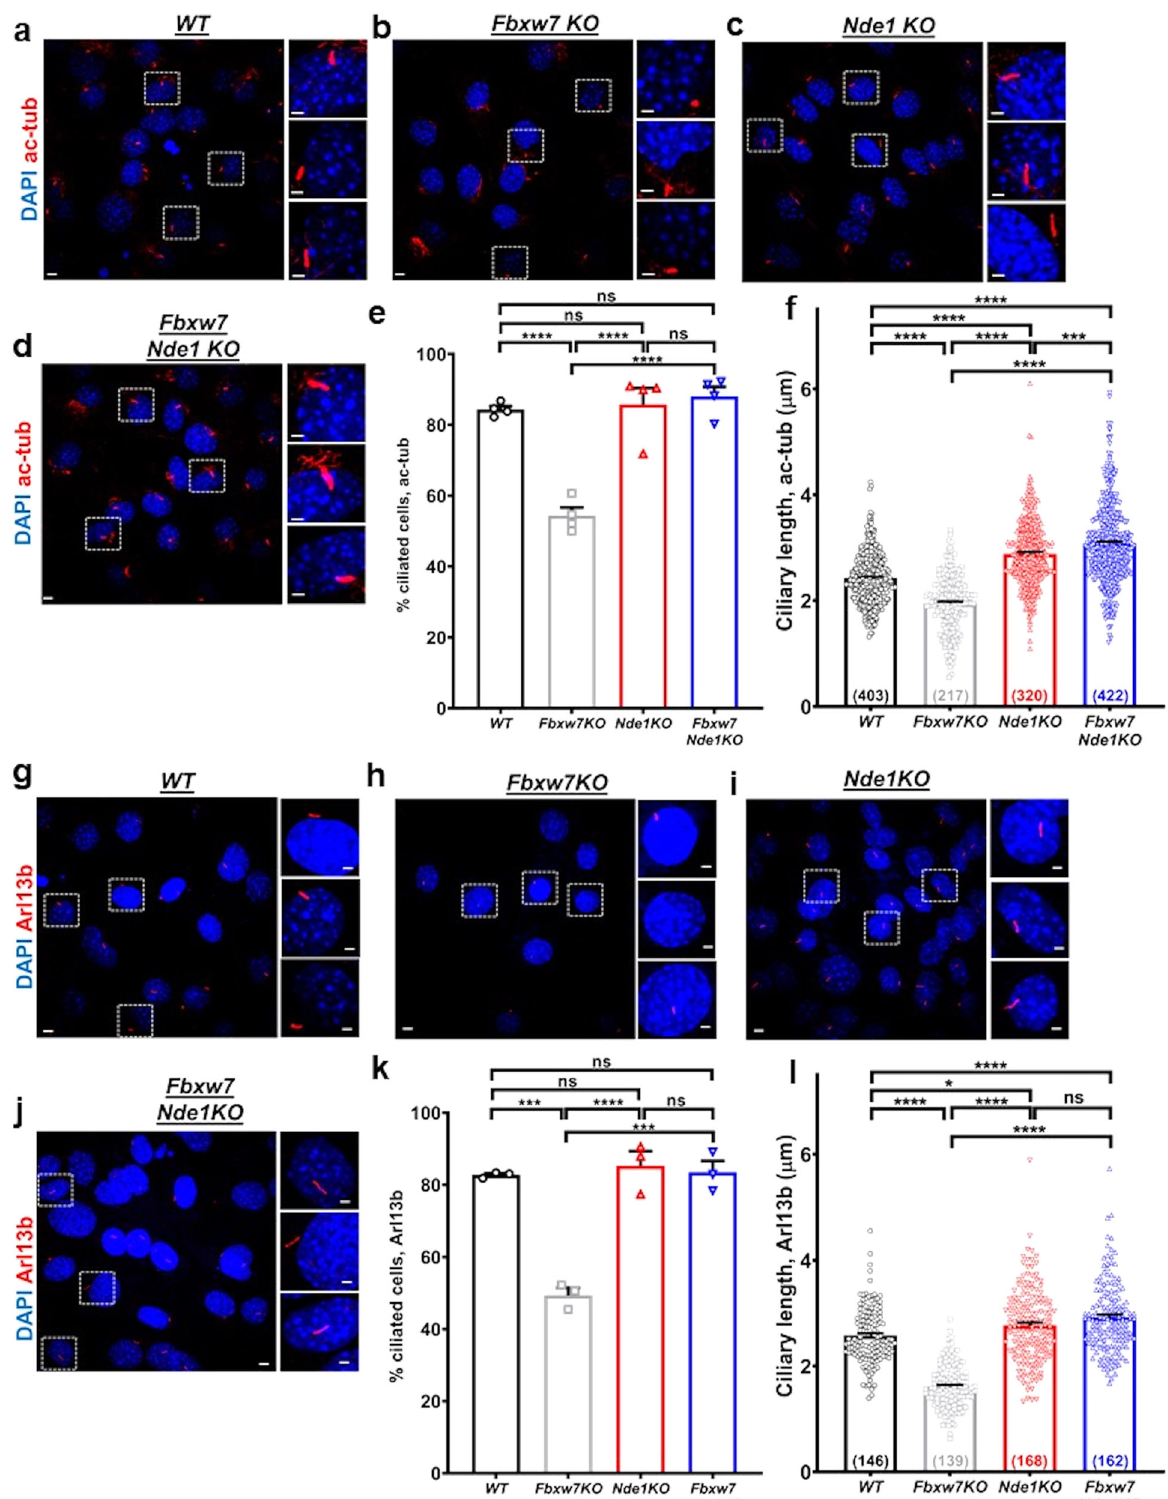
Identi fi cation of TALPID3 as a possible target of FBW7 . Because osteoblast differentiation was partially rescued in double mutant cells, while cilia appeared grossly structurally similar to cilia of Nde1 -null cells, we reasoned that positive regulator(s) of the Hedgehog pathway might be additional potential targets of FBW7 that could accumulate in double mutant cells providing some degree of rescue. Screening all known positive regulators